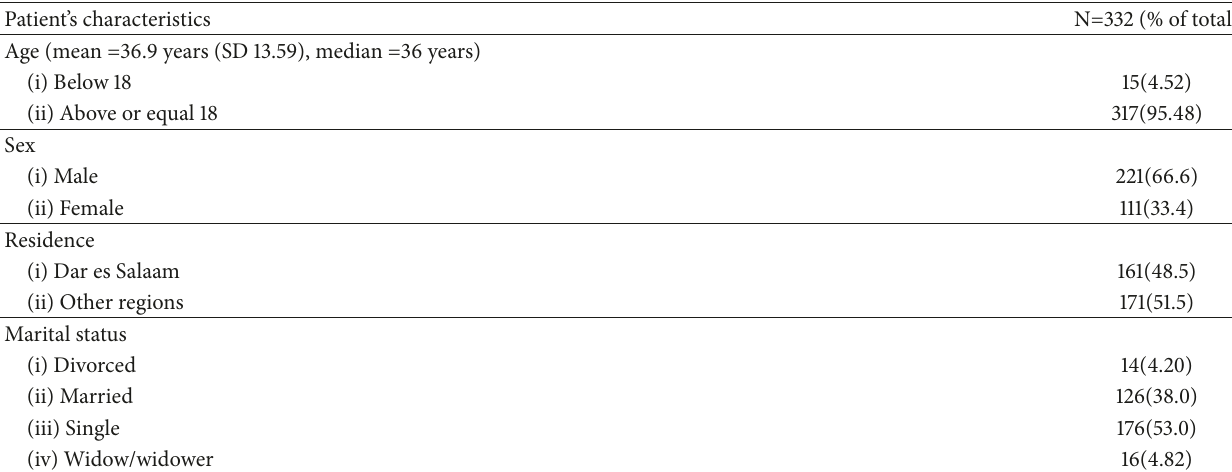
Table 1: Patients’ sociodemographic characteristics